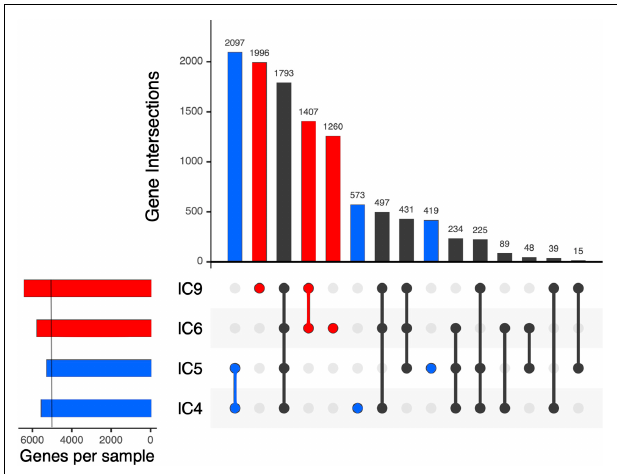
FIGURE 5 | Intersection of the K. pneumoniae gene sets across the samples and patients using UpSet plots. Each vertical bar shows the number of genes common across the samples highlighted by dots below the bar. Subject-specific sets are shown in blue and red for patient A and B, respectively. On the left, a light vertical line denotes n = 5,000 genes.